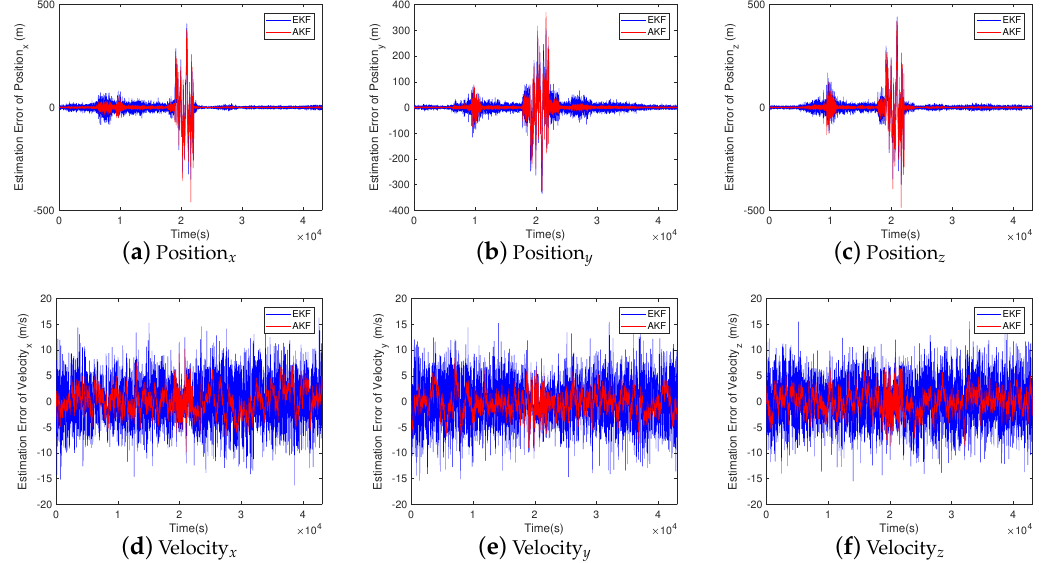
Figure 6. The figure reflects estimation error of each state variable between EKF and AKF.